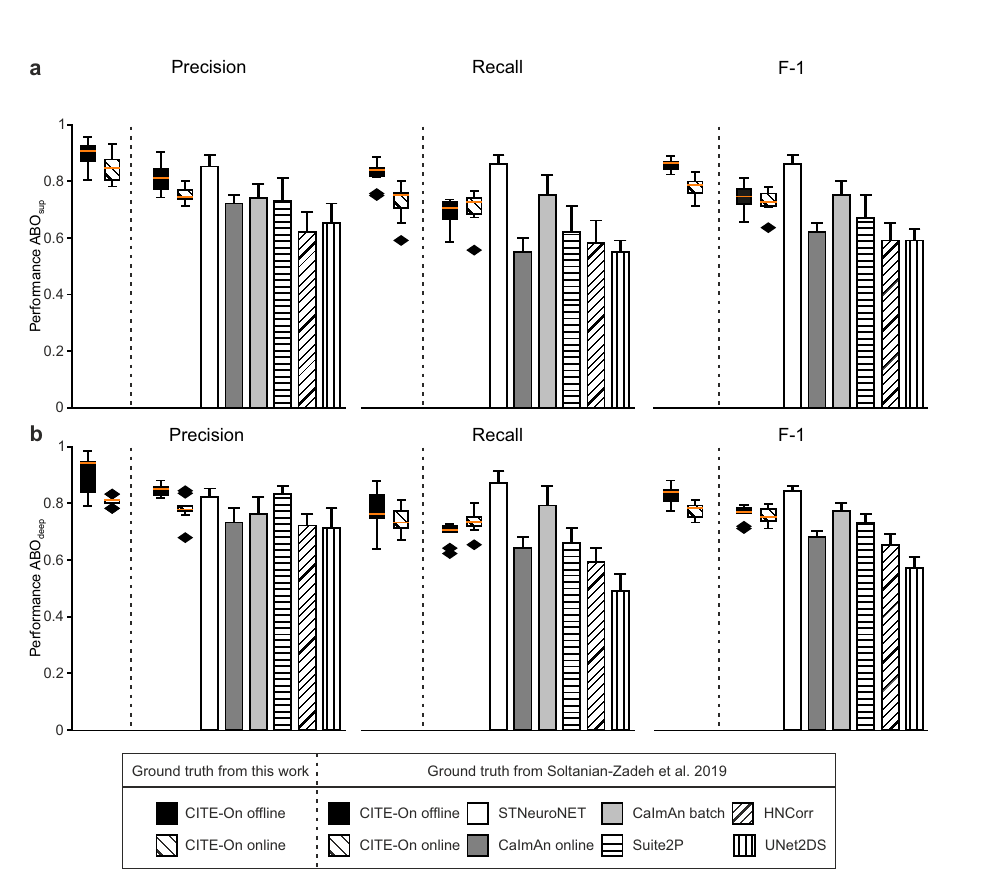
annotation on each frame of the ABO, NF, and VPM datasets. When computing the F-1 score, we tested different sizes of the sliding average, in order to de fi ne the smallest number of frames required to achieve real-time processing. The absolute maximum F-1 score was achieved in 10 frames for the ABO dataset (both ABO sup , and ABO deep , Fig. 8a, b), 20 frames for the VPM dataset (Fig. 8e), and 200 frames for the NF (train and test) dataset (Fig. 8c, d). For the ABO dataset, 0.3 s were necessary to acquire 10 frames (0.00086% of the whole time series of average